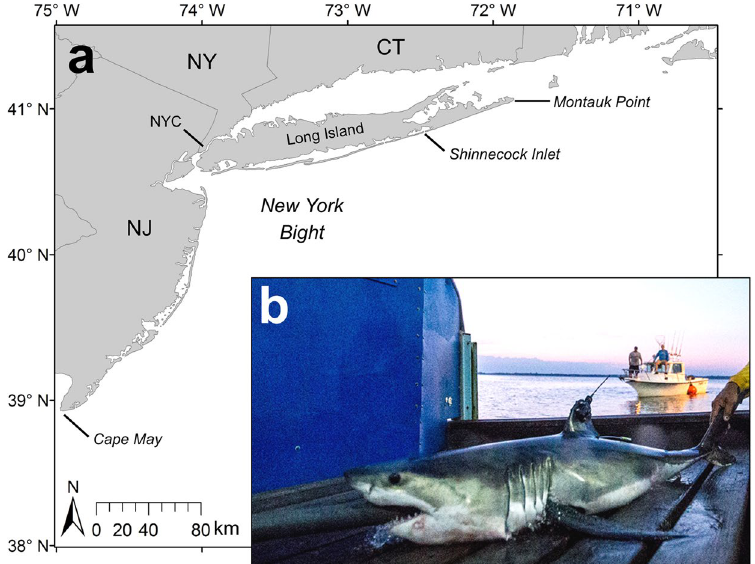
Figure 1. Map of the study site off Long Island, New York in the western North Atlantic ( a ) and photograph of a satellite tagged YOY white shark (WS2) on the M/V OCEARCH boat lift tagging platform ( b